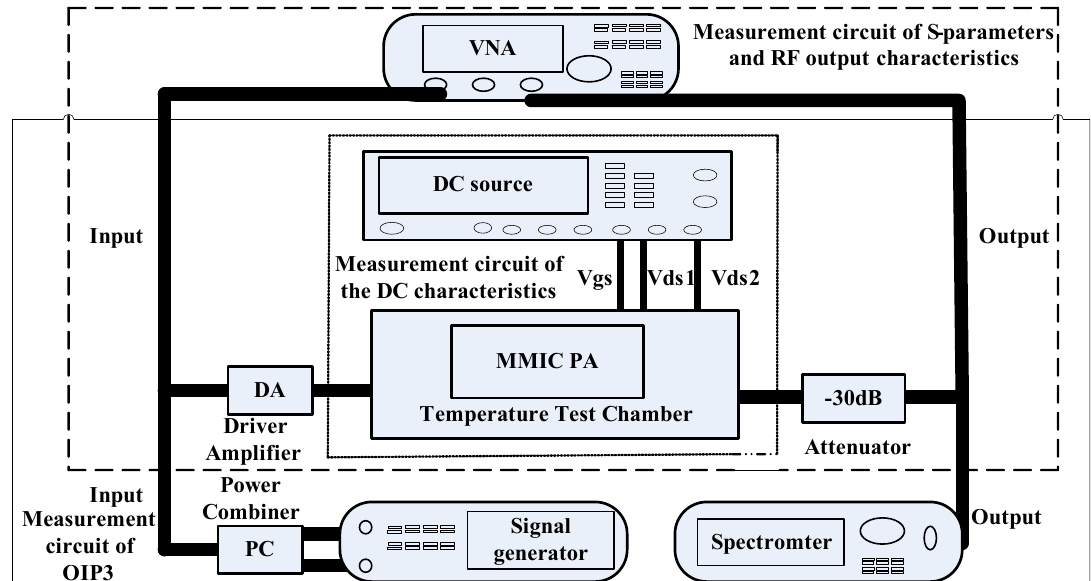
Figure 7. Measurement circuits of MMIC PA.